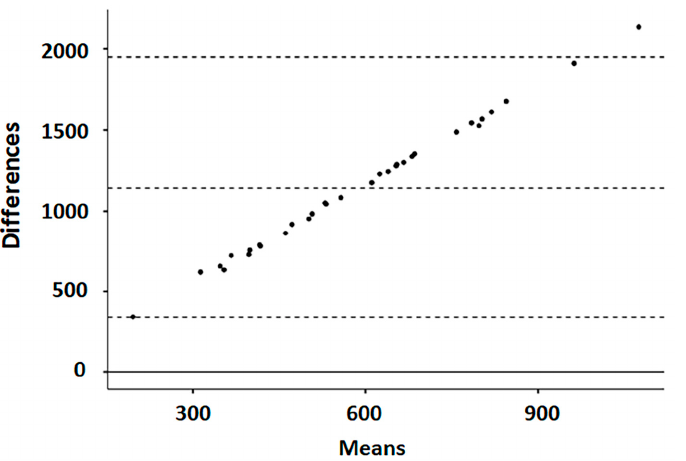
Figure 2. Bland–Altman dispersion plot (average of the two methods against the difference between values) comparing ROMs and TOS assays in small ruminant blood samples. The solid line indicates the height where differences equal to 0 are placed (zero bias line); the central dashed line represents the mean of the differences between the measurements of the two methods (bias); and the two dotted lines at the top and bottom delimit a band that represents the confidence interval limits of the mean of the differences (mean of the differences ± 1.96 × standard deviation).